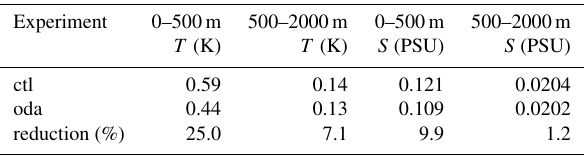
Figure 10. (a) Time series of RMSE of SST from ctl and oda_sst and (b) the distribution of the RMSE ratio (oda_sst / ctl) of SST. The RMSE ratio is calculated with the data of the first 3 months excluded. Table 4. Globally averaged RMSEs of ocean temperature and salin- ity vertically averaged between the surface and 500m and between 500 and 2000m from ctl and oda with the data of the last 6